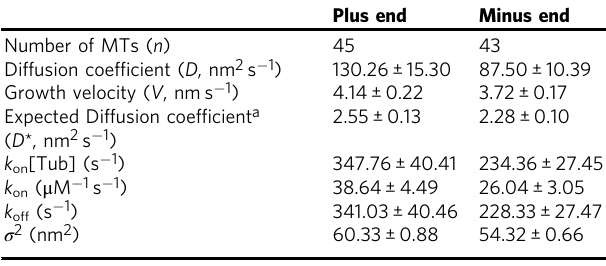
Table 3 Estimated rate constants from MSD